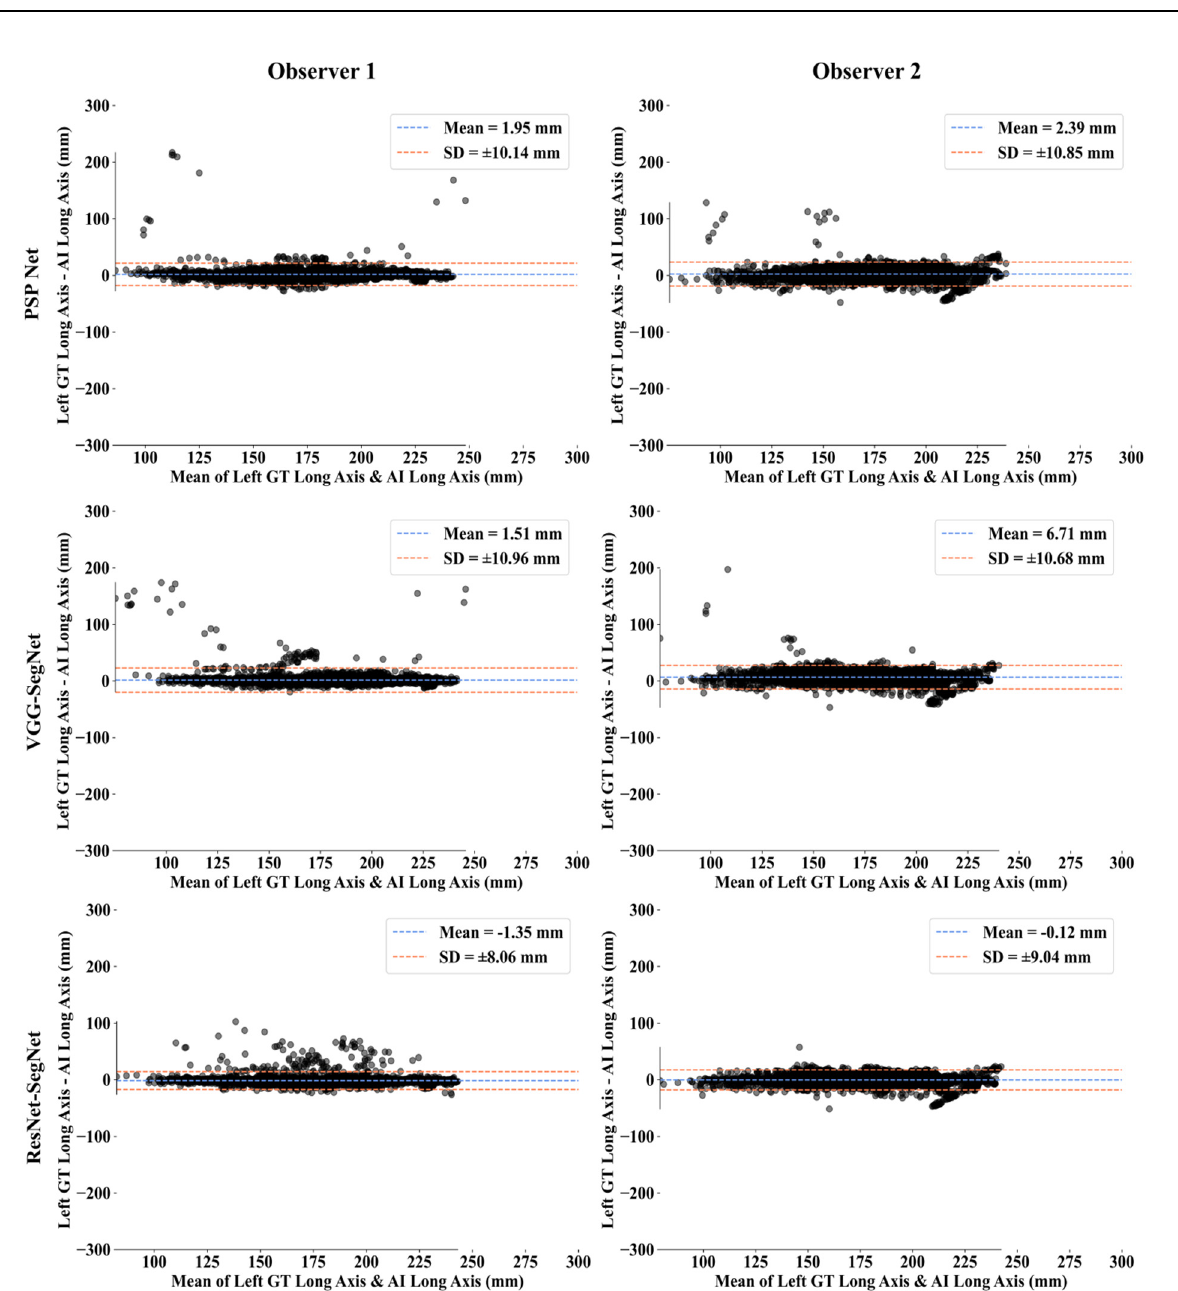
Figure 25. BA for the left LLA using the three: Observer 1 vs. Observer 2.